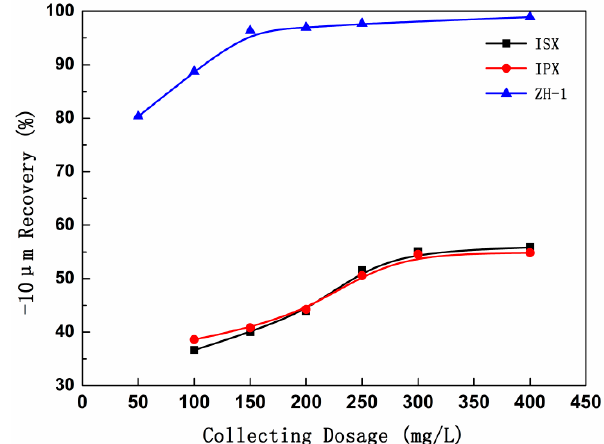
Figure 5. Relationship between the collector dosage and the recovery of fine-grained malachite (pH = 8.5).